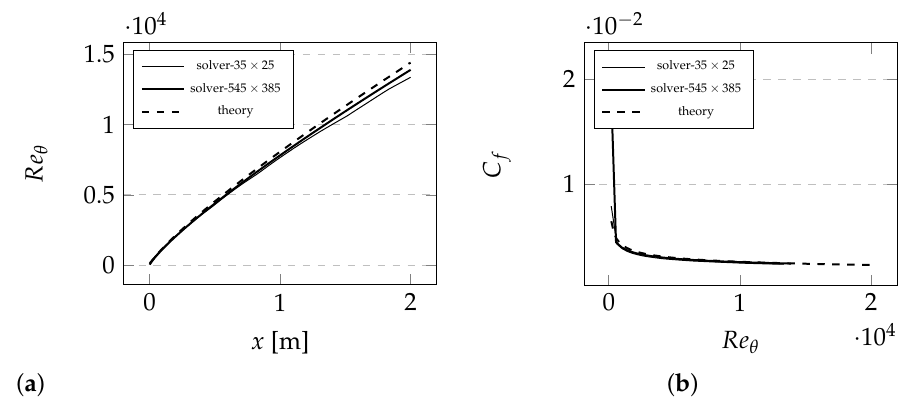
Figure 11. ( a ) Re θ as a function of x and ( b ) C f as a function of Re θ for the flat plate case.